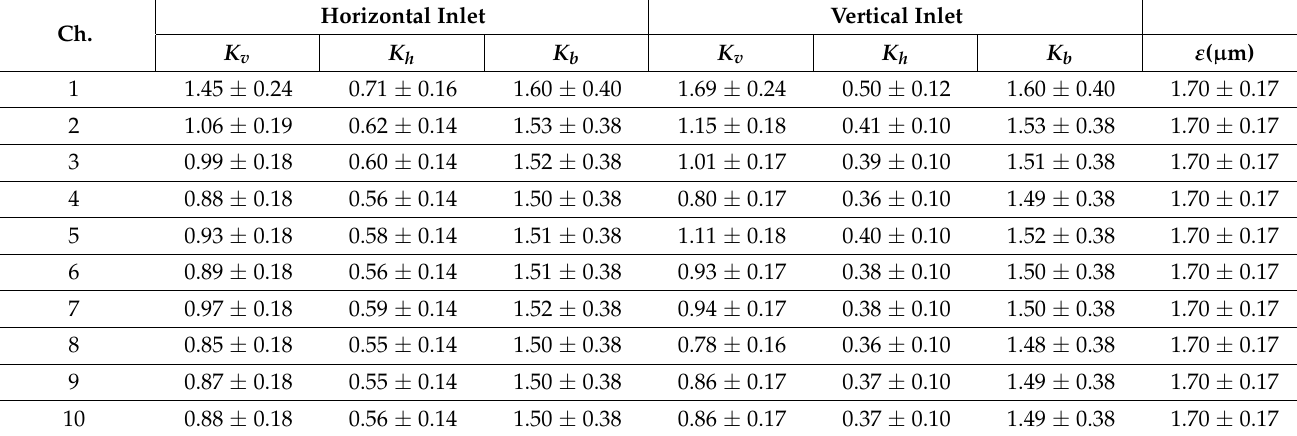
Table 1. Best-estimate parameters after the calibration against the pressure drop characterization tests. Horizontal Inlet Vertical Inlet Ch. K v K h K b K v K